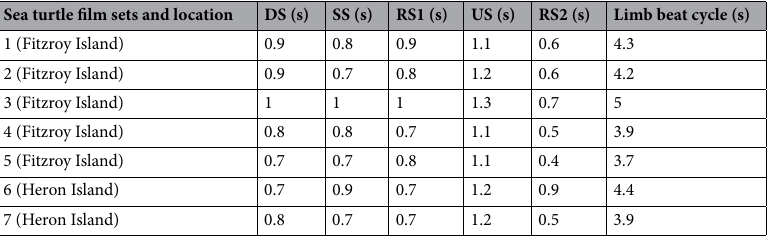
Table 1. Amount of time the flipper tip spends in each of the five stages, data from the Sagittal plane. Refer to Supplementary Fig. S1 for swimming